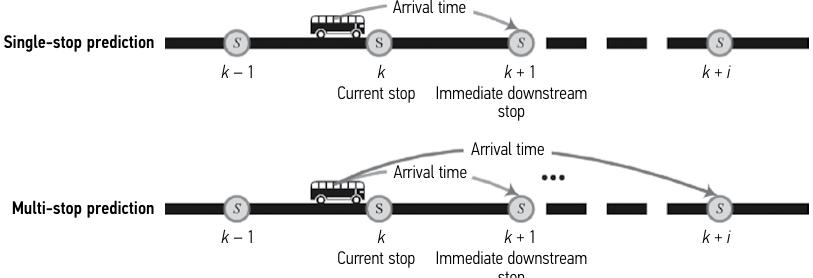
Fig. 1. An example of single-stop and multi-stop